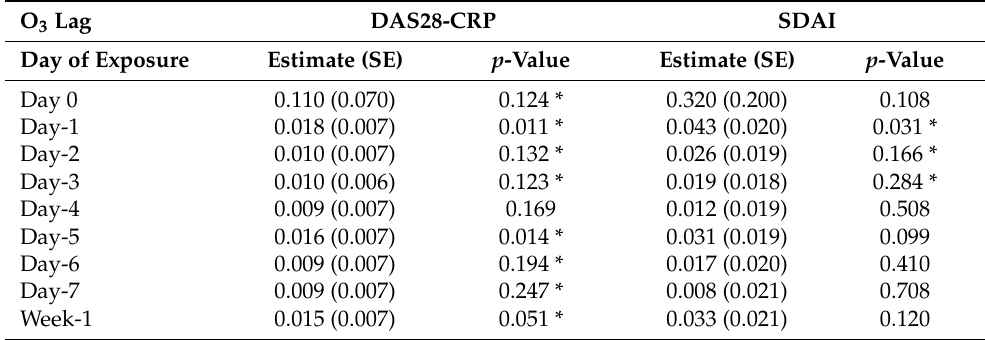
Table 5. Associations between O 3 short-term exposure and RA disease